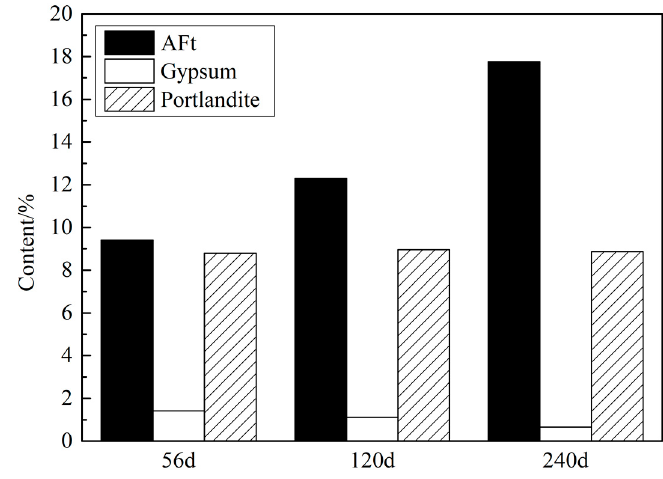
Figure 9. Phase content of cement mortar added with 7.2% SO 3 .